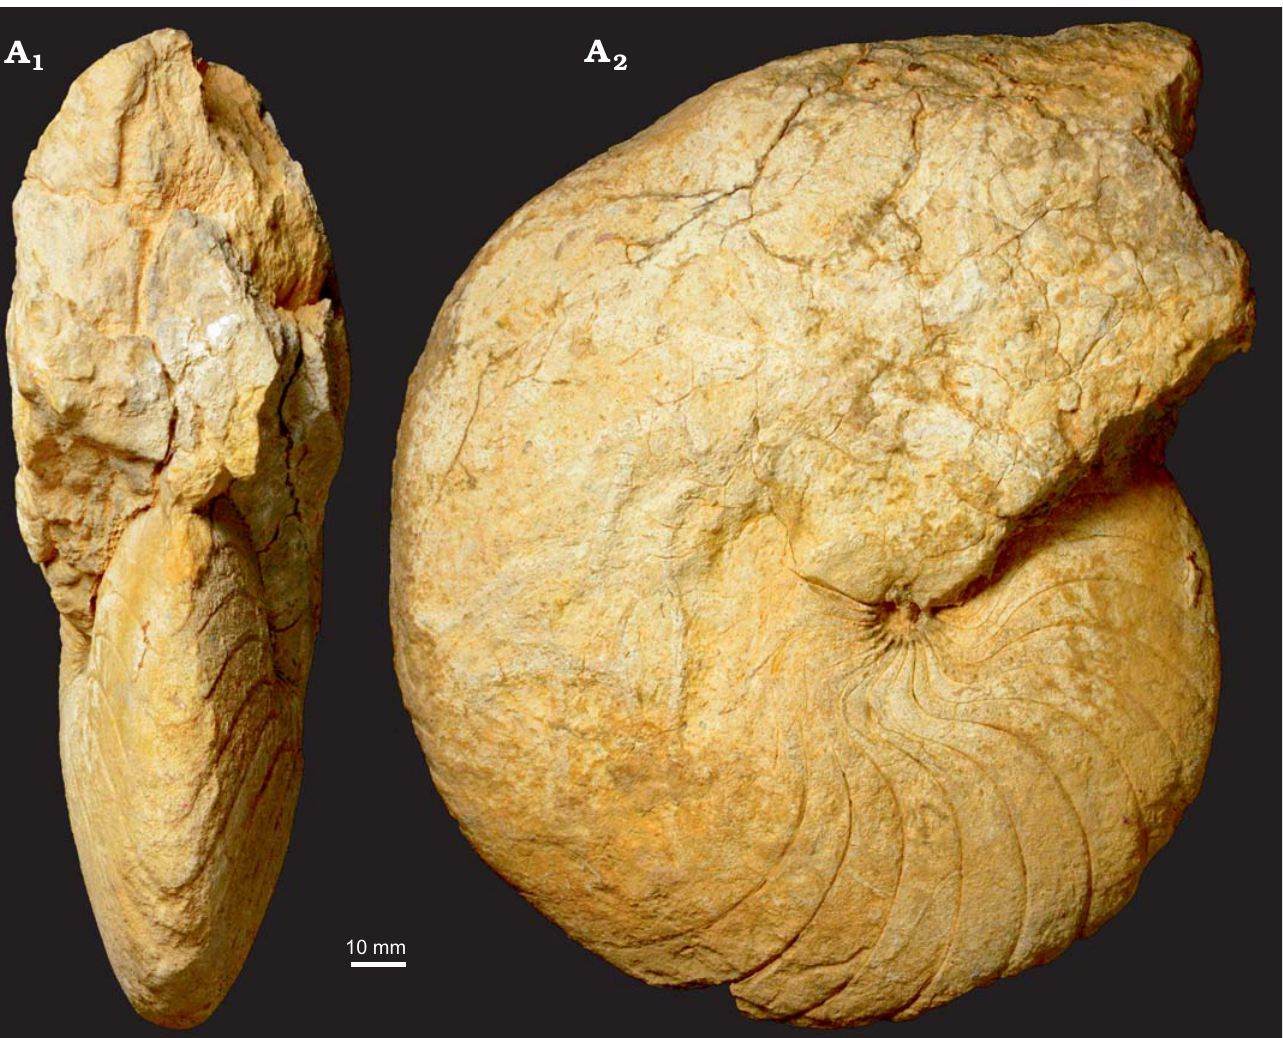
Fig. 3. Hercoglossid nautiloid Angulithes mermeti (Coquand, 1862), AFK 225 from the Cenomanian of Wadi Ghonima, Egypt, in apertural (A 1 ) and lateral (A 2 )